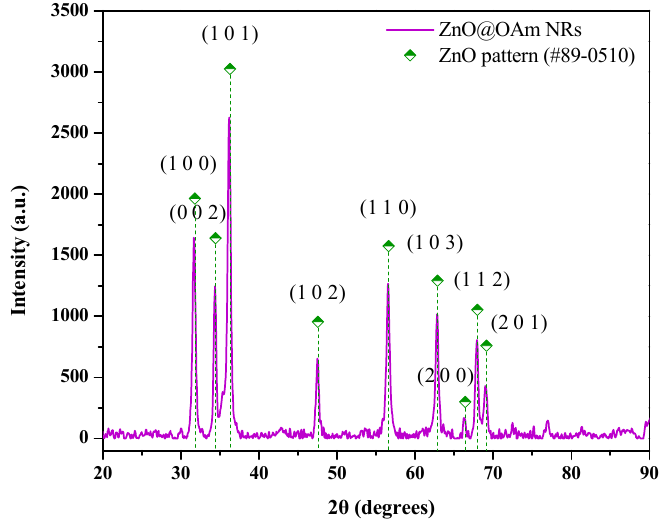
Figure 1. X-ray diffraction (XRD) pattern of the synthesized ZnO@OAm NRs with the main diffraction peaks of ZnO.